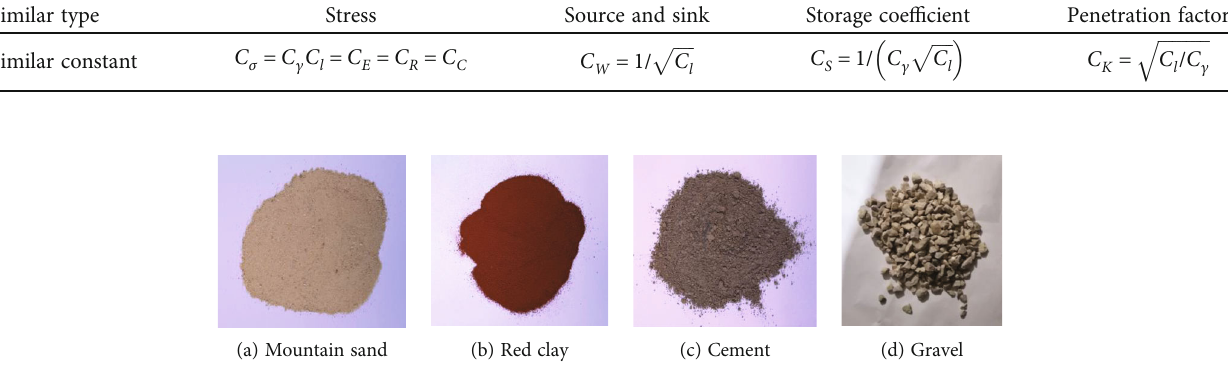
Figure 1: Raw materials for preparing similar